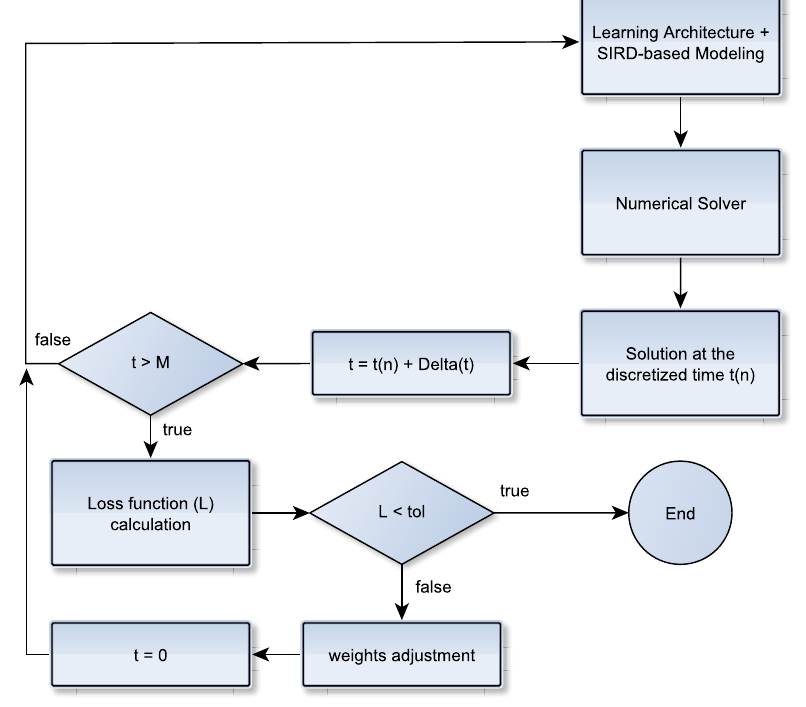
Figure 3. Illustration of the parameter calibration